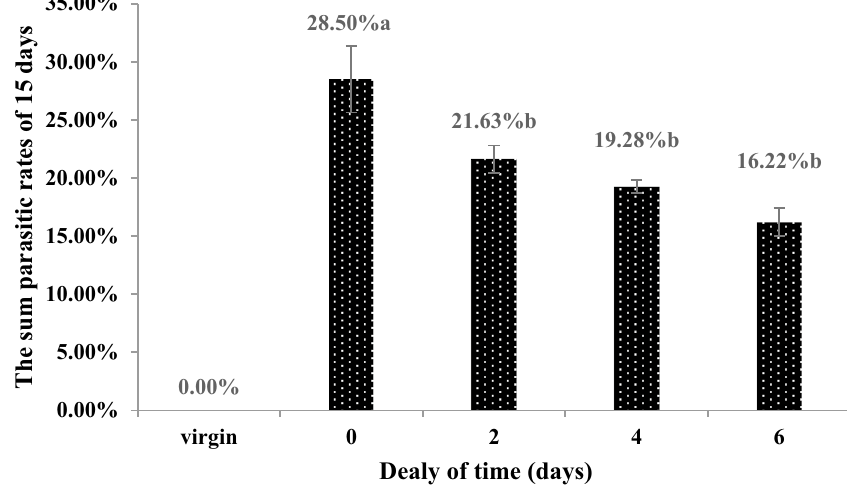
Figure 9. The parasitic rates of females C. japonicus at different delayed mating. Data in the figure is mean ± standard error, different letters indicate significant differences in Duncan’s test, with a probability of 5%.